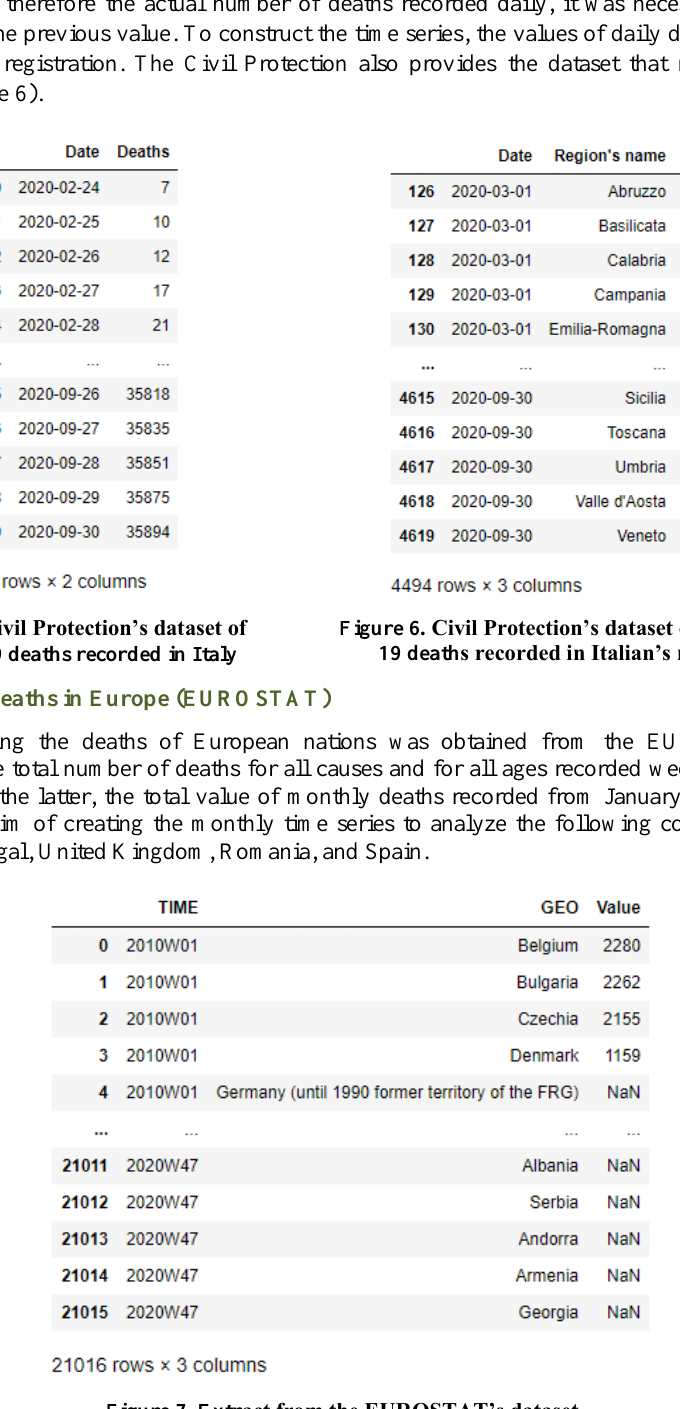
Figure 7. Extract from the EUROSTAT’s dataset